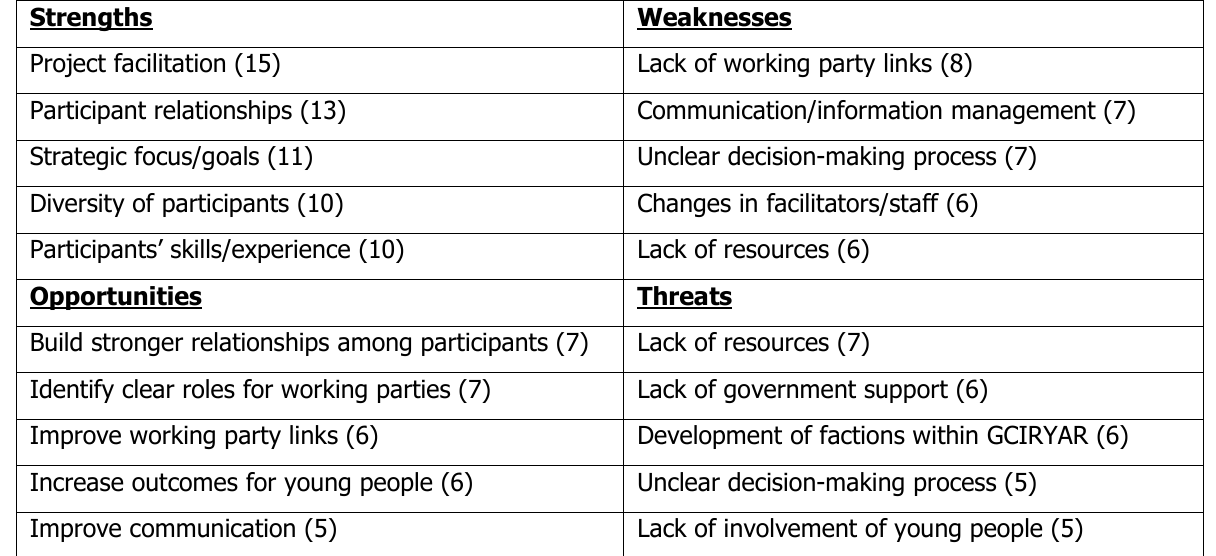
GCIRYAR SWOT analysis (top five responses for each SWOT criteria)